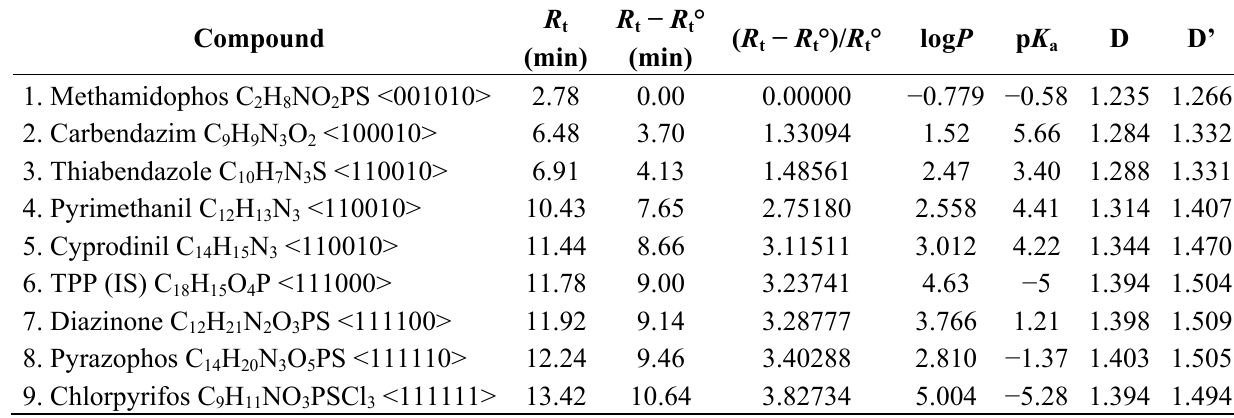
Table 1. Vector property (cyc dimensions for